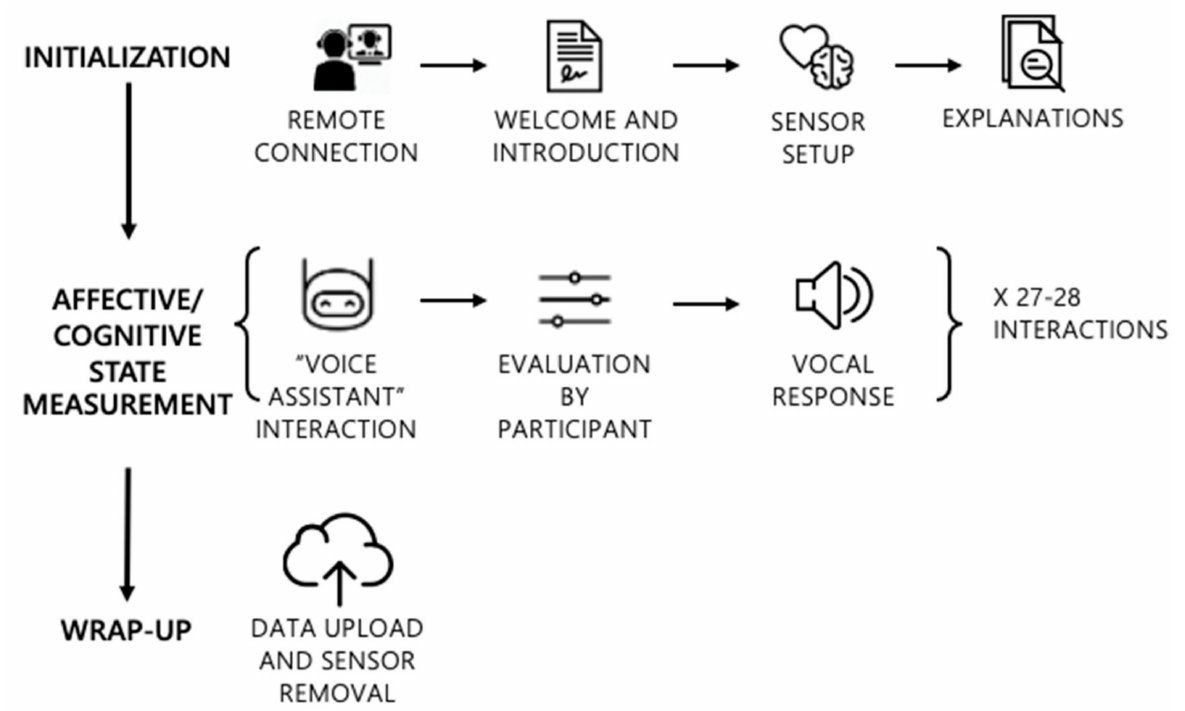
Figure 4. Graphical summary of the experiment